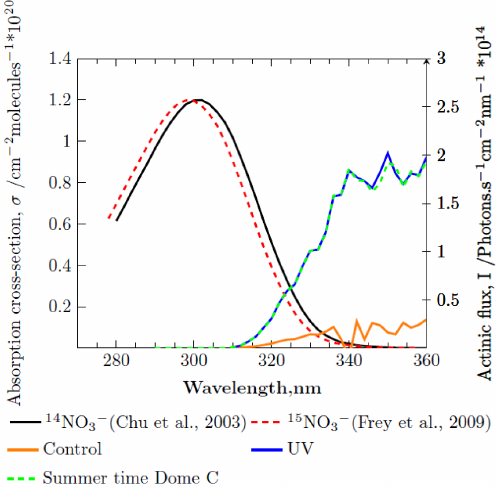
Figure 2. The absorption cross section of 14 NO − measured in the 3 liquid phase and the absorption cross section of 15 NO − determined 3 using the ZPE shift model (left y axis). The absorption cross sec- tion of 15 NO − was derived by applying an average shift of 0.5nm 3 on 14 NO − . The 2nm shift has been manually emphasized (note that 3 in reality the two curves nearly overlap). Plotted on the right y axis is the solar spectrum derived using the TUV (Tropospheric Ultravi- olet Visible) model at Dome C conditions (ozone column depth of 297DU and an albedo of 0.9) and expected UV fluxes in the pres- ence of the plexiglass plate